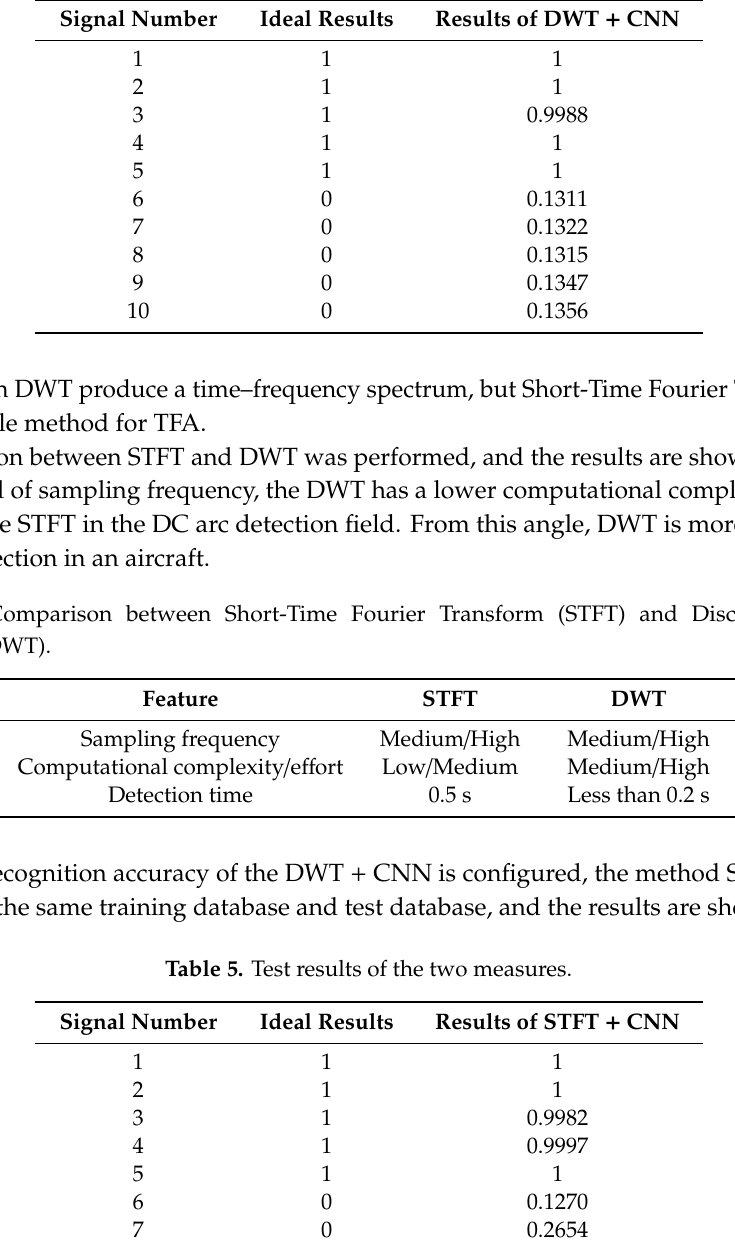
Table 3. Test results of the two measures.